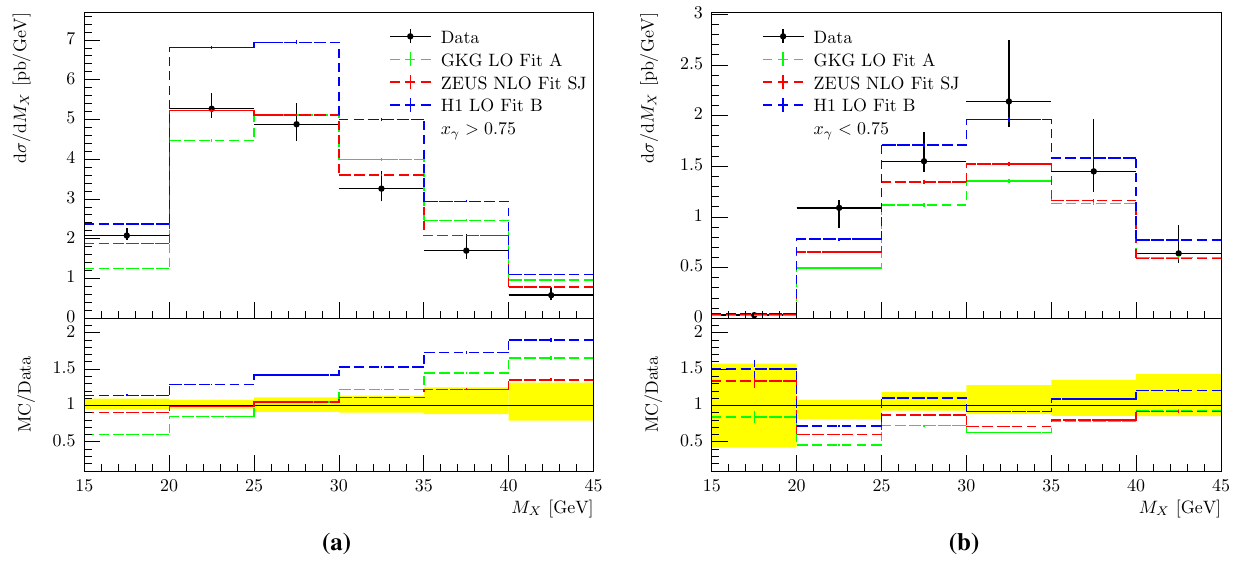
Fig. 11 The model without gap suppression using the three dPDFs: H1 Fit B LO (blue lines), GKG LO Fit A (green lines) and ZEUS SJ (red lines) compared to ZEUS data on M X in the direct-enhanced ( a ) and resolved-enhanced ( b ) regions